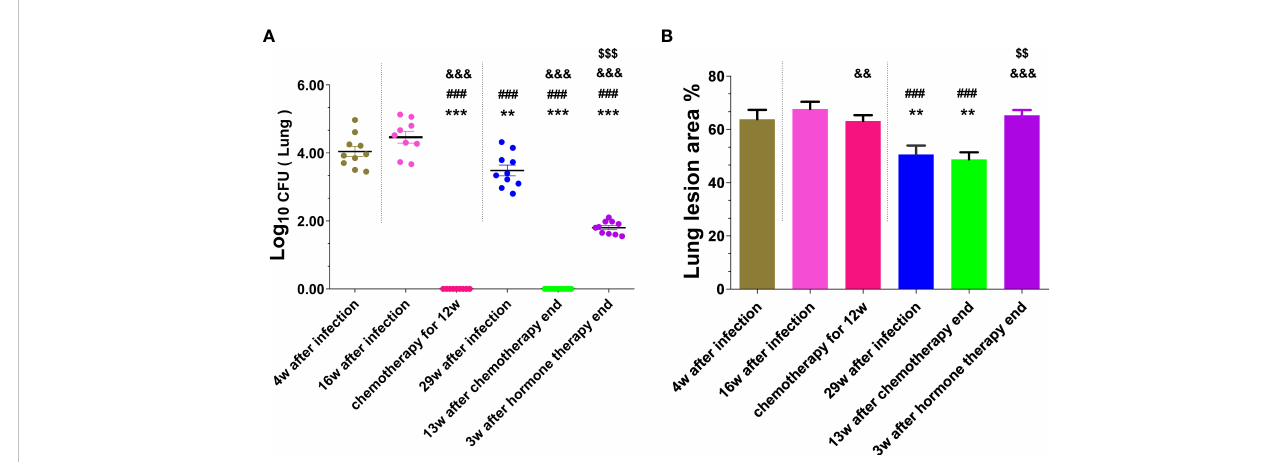
FIGURE 2 The number of viable MTB and histopathological changes in the lung tissues were obtained from mice at different stages of mouse LTBI model preparation. (A) Lung CFUs; (B) Lung lesion area%. Comparison with 4w after infection group: ** P < 0.01, *** P < 0.0001; Comparison with 16w after infection group: ### P < 0.0001; Comparison with 29w after infection group: && P < 0.01, &&& P < 0.0001; Comparison with chemotherapy for 12w group or 13w after chemotherapy end: $$ P < 0.01, $$$ P <